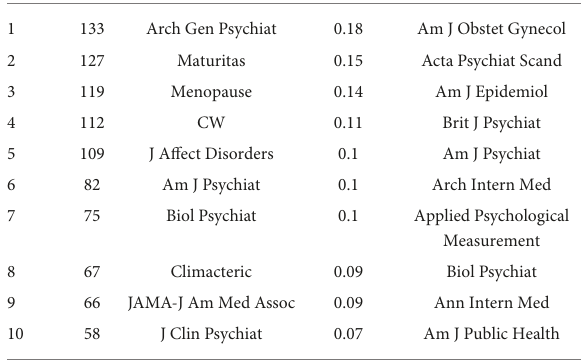
TABLE 8 Top 10 co-cited journals related to